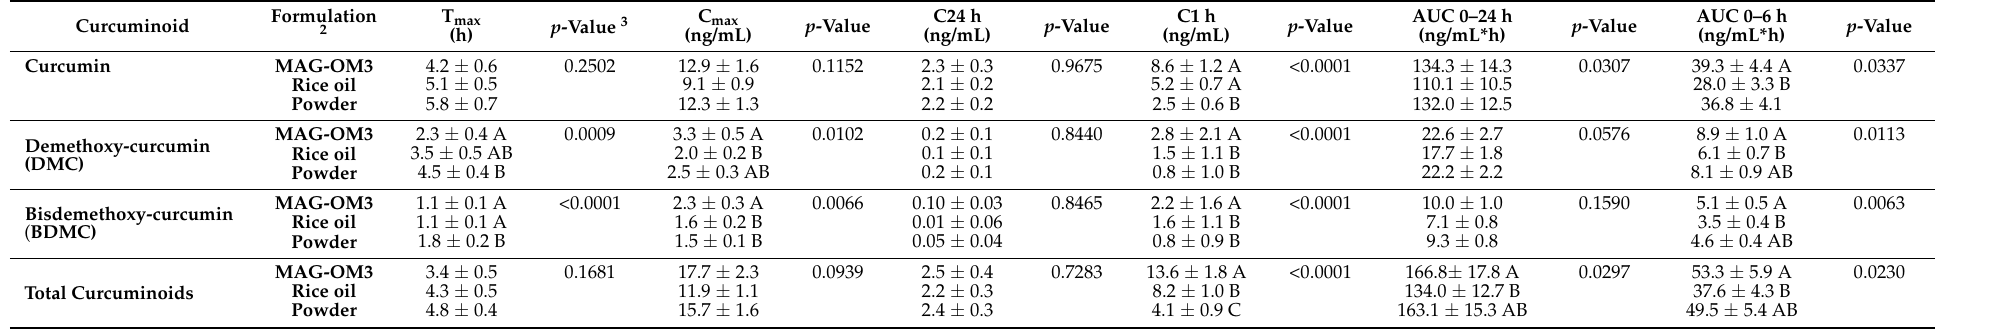
Table 4. Pharmacokinetics parameters of each curcuminoid when provided with a different formulation 1